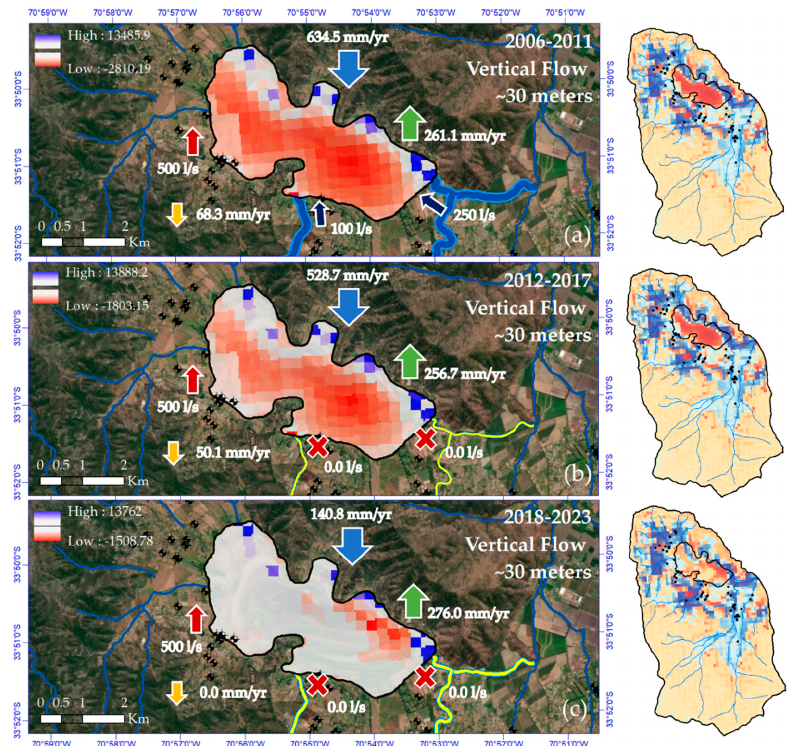
Figure 5. Vertical (recharge and discharge) instantaneous flow (m 3 /s) at 30 m deep (boundary between layers 2 and 3) at the end of each MODFLOW simulation for the Aculeo basin/lagoon. The (daily time- step) simulation was carried out for a spatial resolution of 250 square meters and using the initial conditions of three 5-year periods ( a ) 2006–2011, ( b ) 2012–2017, and ( c ) 2018–2023. The lagoon’s water levels calibrated for each period are 350.92, 349.66, and 345.0 m.a.s.l., which are associated with depths of 5.9, 4.6, and 0 m, respectively. The aquifer area was delineated in concordance with [17]. The fluxes: annual rainfall accumulation (blue arrow) in mm/year; annual evapotranspiration (green arrow) in mm/year; the recharge (yellow arrow) in mm/year; the pumping rate (red arrow) in L/s; and the lagoon’s tributaries (dark-blue arrows) in L/s. The map on the right side shows the discharge and recharge rates for the whole Aculeo